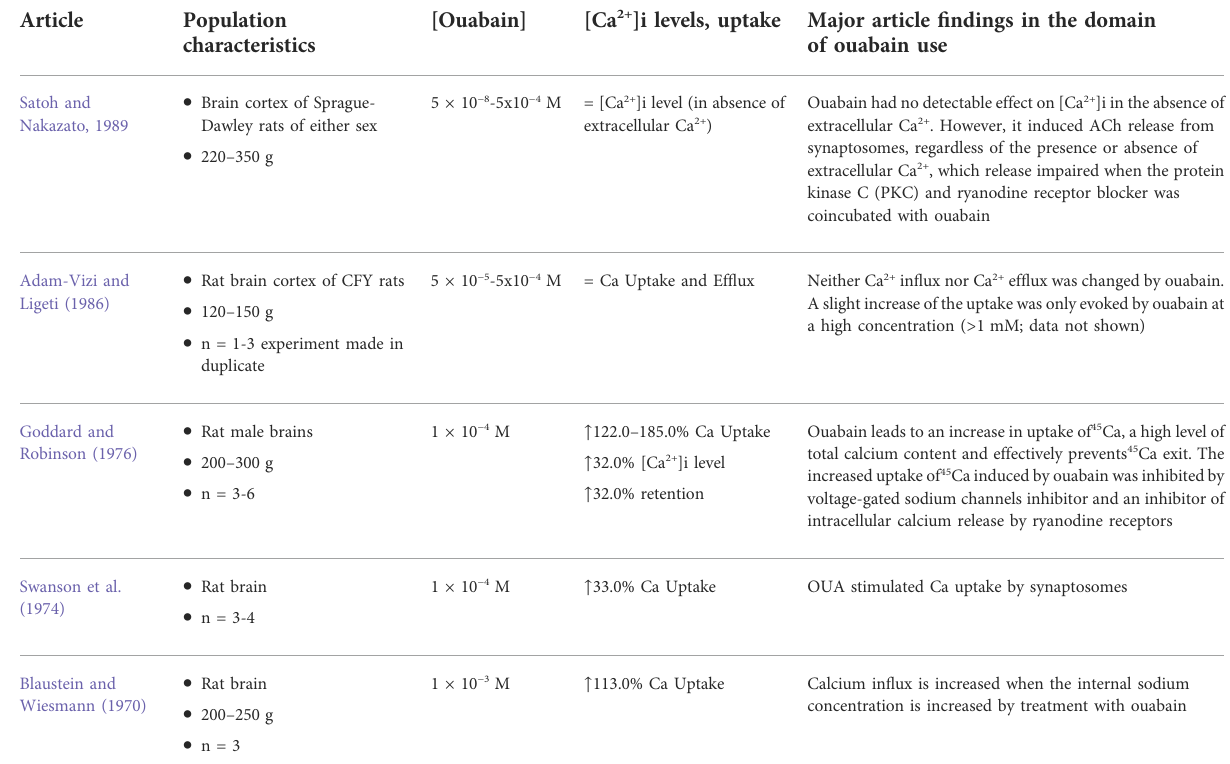
TABLE 2 Summary of synaptosomes